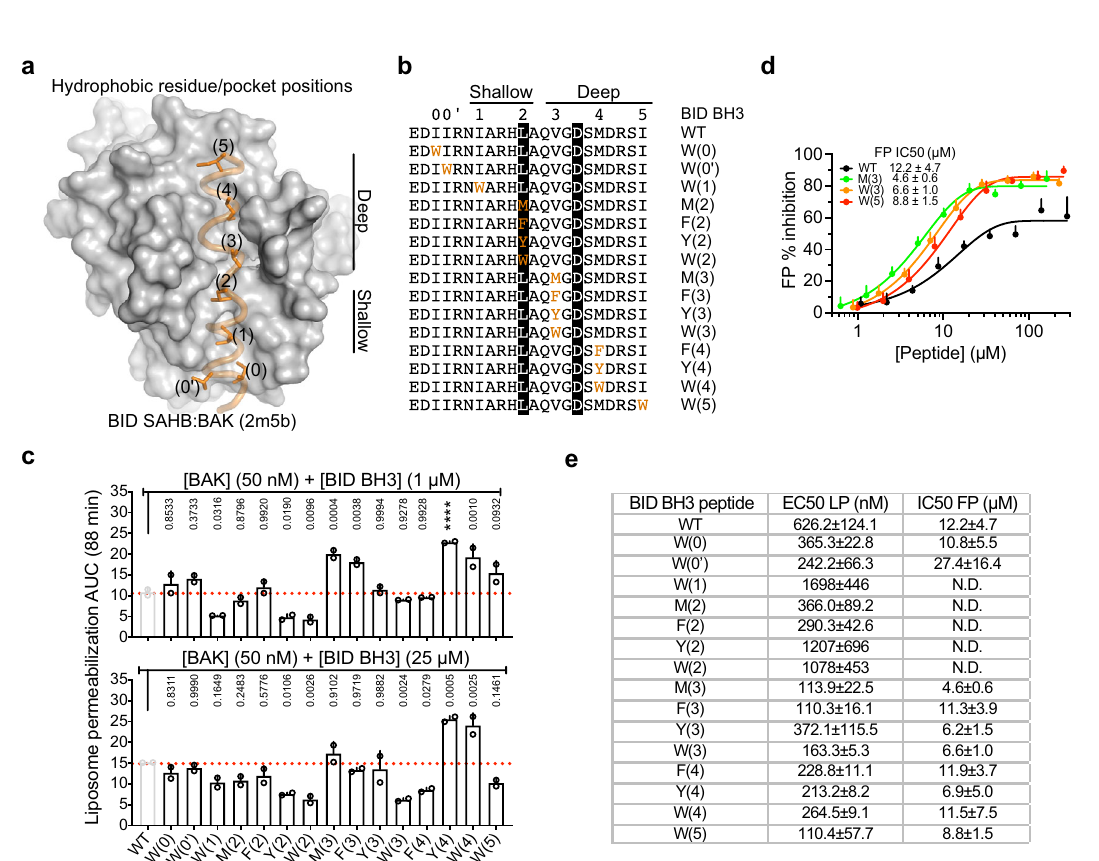
Fig. 3 BAK autoactivation and direct activation cooperate in cells. a , b Schematic of minimalist BAK ± BID apoptotic pathway reconstituted in BCL2allKO HCT116 cells. c Apoptosis of BCL2allKO HCT116 cells reconstituted with Dox-inducible V74A and D83A mCherry-BAK (mC-BAK) monitored for 48 h by IncuCyte imaging uptake of cell-impermeable dye SYTOX Green. Data are presented as mean + SD of one representative from n = 3 experiments each of n = 3 technical replicates. Dox concentration (ng/mL) is inset. d AUC of kinetic traces in ( c ) and representative immunoblots from n = 2 independent experiments. The purple line indicates similar cell death induced at ~10-fold higher expression level for D83A compared to V74A. The ratio of background- corrected mC-BAK/actin is shown in purple for 50 ng/mL and 500 ng/mL Dox. e Apoptosis of BCL2allKO HCT116 cells reconstituted with Dox-inducible V74A and D83A mC-BAK monitored for 48 h by IncuCyte imaging uptake of cell-impermeable dye SYTOX Green. Culture medium ± qVD (black arrows) or TRAIL + CHX (T/C) ± qVD (red arrows) were added at 6 h after addition of Dox. Data are presented as mean + SD of one representative of n = 4 experiments each of n = 3 technical replicates. Dox concentration (ng/mL) is inset. f AUC of kinetic traces in ( e ) and representative immunoblots from n = 2 independent experiments after 24 h of incubation with Dox + qVD. BAK, arrowhead; *, nonspeci fi c band.